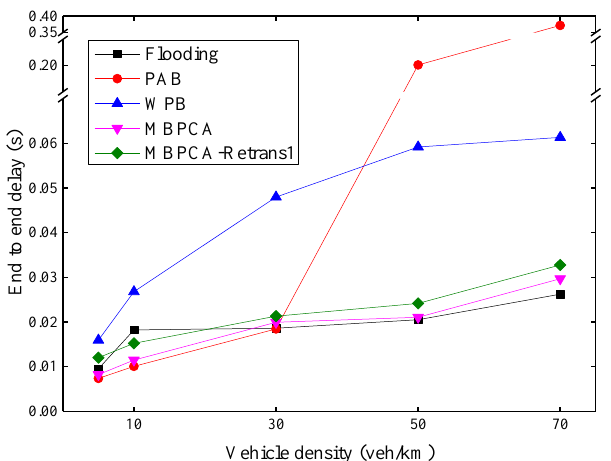
Figure 13. Average end-to-end delay under different vehicle densities.